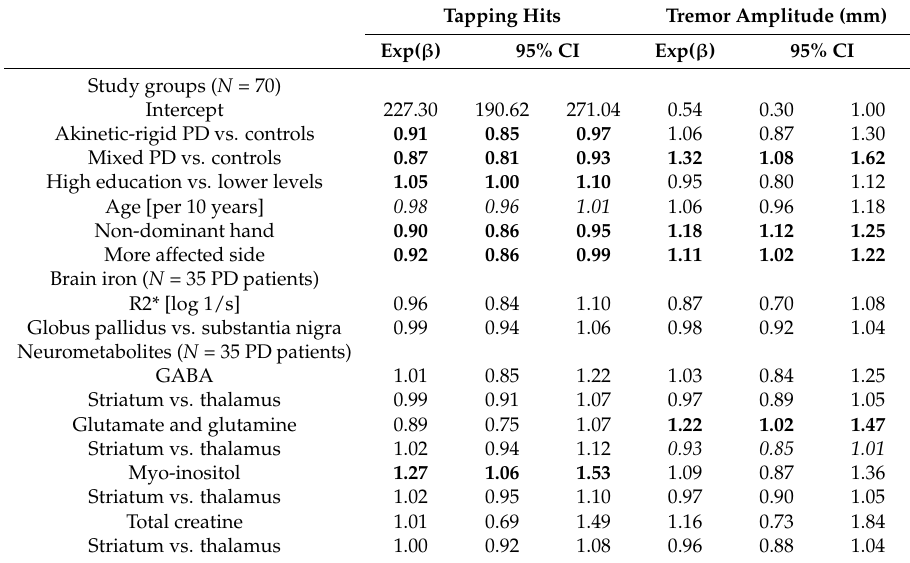
Table 4. Brain iron, neurometabolites, and other potential predictors of fine motor skills determined by a mixed model in 35 Parkinson patients and 35 controls.